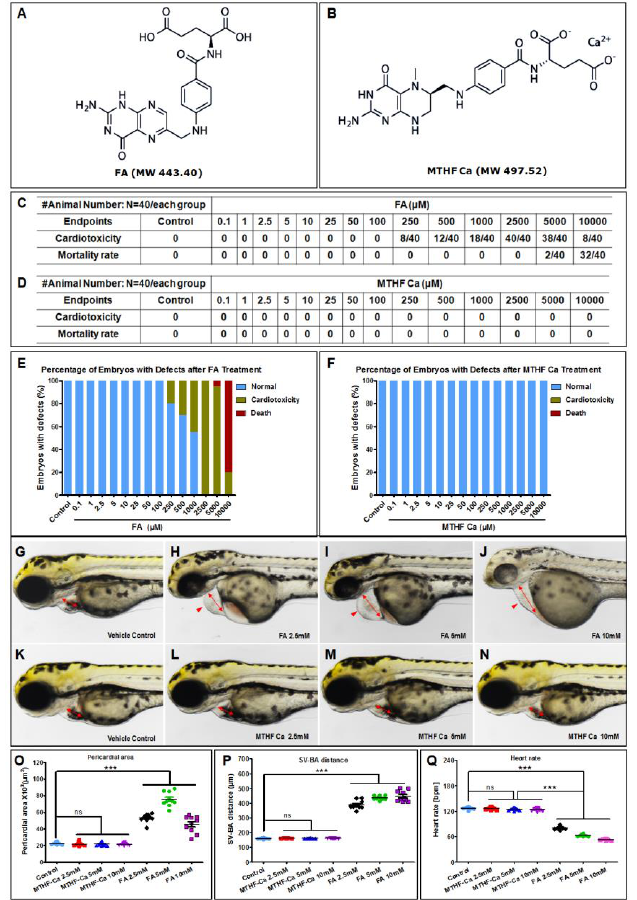
Figure 1. FA, but not MTHF-Ca, causes cardiotoxicity in vivo. ( A ) Chemical structural formulae of FA and ( B ) MTHF-Ca. FA, but not MTHF-Ca, caused cardiotoxicity in zebrafish at 3 dpf. ( C , E ) The endpoints of cardiotoxicity in FA were from 250 to 10,000 μM. The lowest cardiotoxicity at 250 μM of FA was 8/40, while the highest one was 40/40 at 2500 μM of FA. The mortality rates at 5000 and 10,000 μM of FA were 2/40 and 32/40. ( D , F ) There was no cardiotoxicity or embryonic defects in MTHF-Ca. ( G – N ) Representative bright-field images of zebrafish embryos at 3 dpf treated with vehicle control (fish water), FA (2.5 mM, 5 mM, and 10 mM) or MTHF-Ca (2.5 mM, 5 mM, and 10 mM). Compared with control or MTHF-Ca, FA-treated embryos presented pericardial oedema (red arrowheads), reduced contractile force, and reduced precardial blood congestion as sign of manifest heart failure. (Figures S1 and S2). Heartbeat and circulation in caudal vein (CV) was visible in the control fish and MTHF-Ca-treated fish but was abnormal in FA-treated fish. ( O , P ) Pericardial area and SV-BA distance in FA were increased compared to that in MTHF-Ca, ( Q ) while the heart rate was decreased. FA: folic acid; MTHF-Ca: 6S-5-methyltetrahydrofolate-calcium; SV-BA: sinus venosus and bulbus arteriosus; dpf, days postfertilization. *** p < 0.0001; ns: not significant.